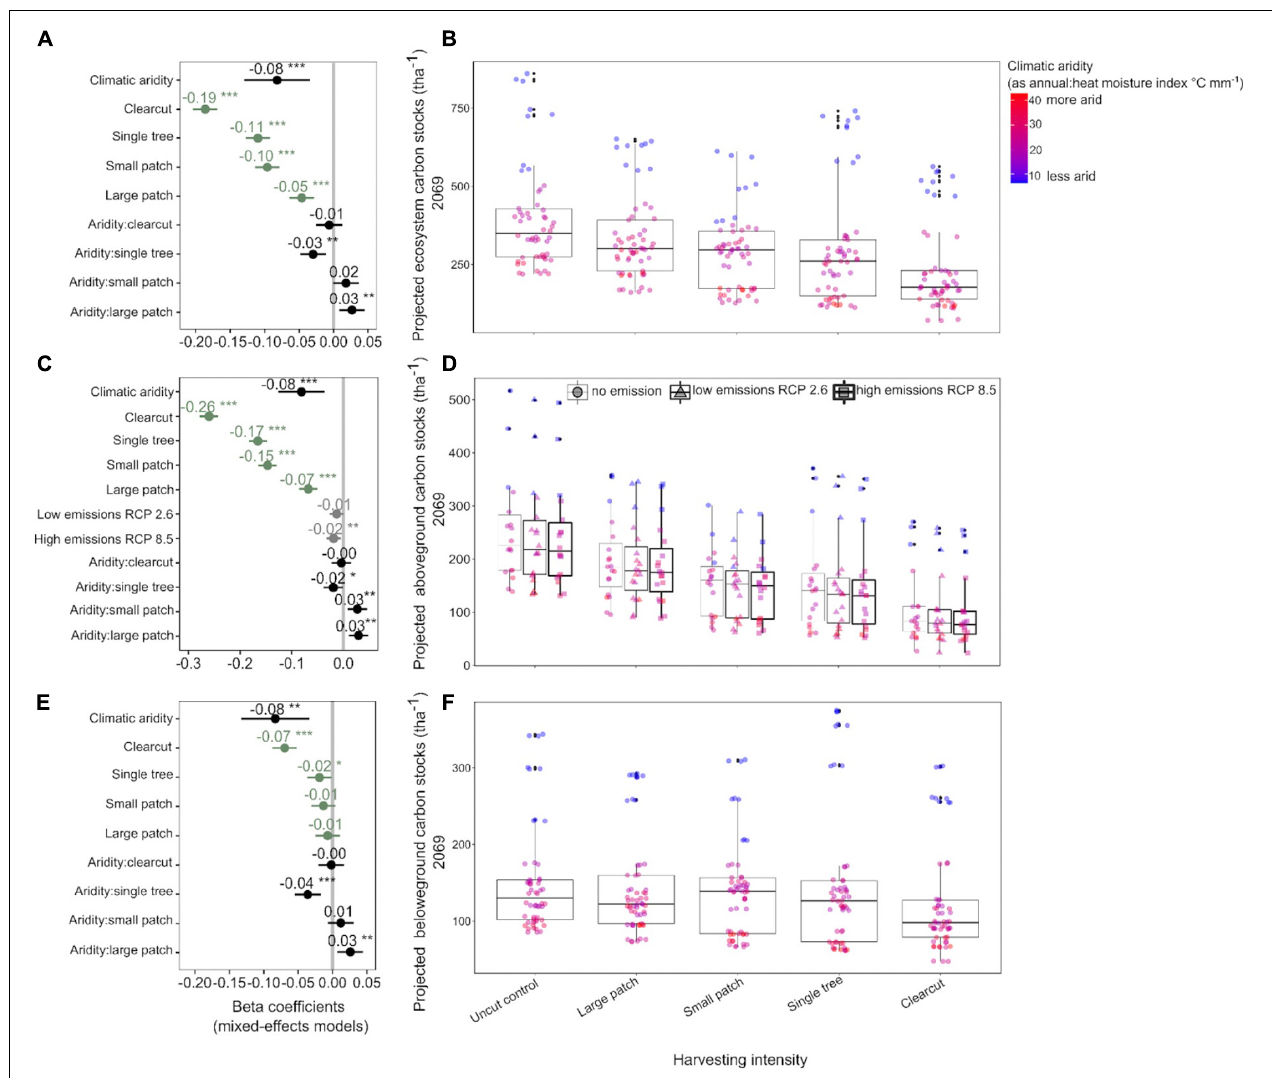
FIGURE 2 | Response of model projected Douglas-fir forest carbon stocks (2069) to harvesting intensity, climatic aridity (1981–2010 averages), and climate change (low-emissions RCP 2.6 and high-emissions RCP 8.5). Carbon stocks were projected using the Carbon Budget Model of the Canadian Forest Sector (CBM-CFS3; Kurz et al., 2009). Panels (A , C,E) present standardized coefficients of linear mixed-effects models for ecosystem, above- and belowground carbon stocks, respectively. Standardized coefficients illustrate the effect of the predictors on the response variable in terms of their standardized effect sizes. Circles indicate average estimates and lines indicate 95% confidence intervals (see Table 3 ). For harvesting treatments, each coefficient (green color) represents the difference between the uncut control and a given treatment and for climate change, each coefficient represents the difference between no emission and a given scenario. *** P < 0.001; ** P < 0.01; * P < 0.05. Panels (B , D,F) present the response of ecosystem, above- and belowground carbon stocks to harvesting intensity, climatic aridity, and climate change, respectively. The aridity index was calculated as [mean annual temperature + 10]/[mean annual